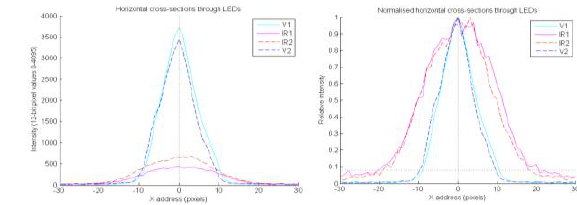
Figure 9. Intensity profiles of violet and IR LEDs, and normalised profiles (right).